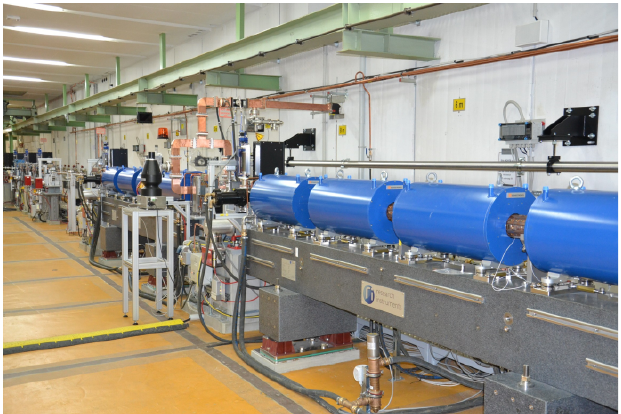
Figure 13. Finished setup of the ARES linac